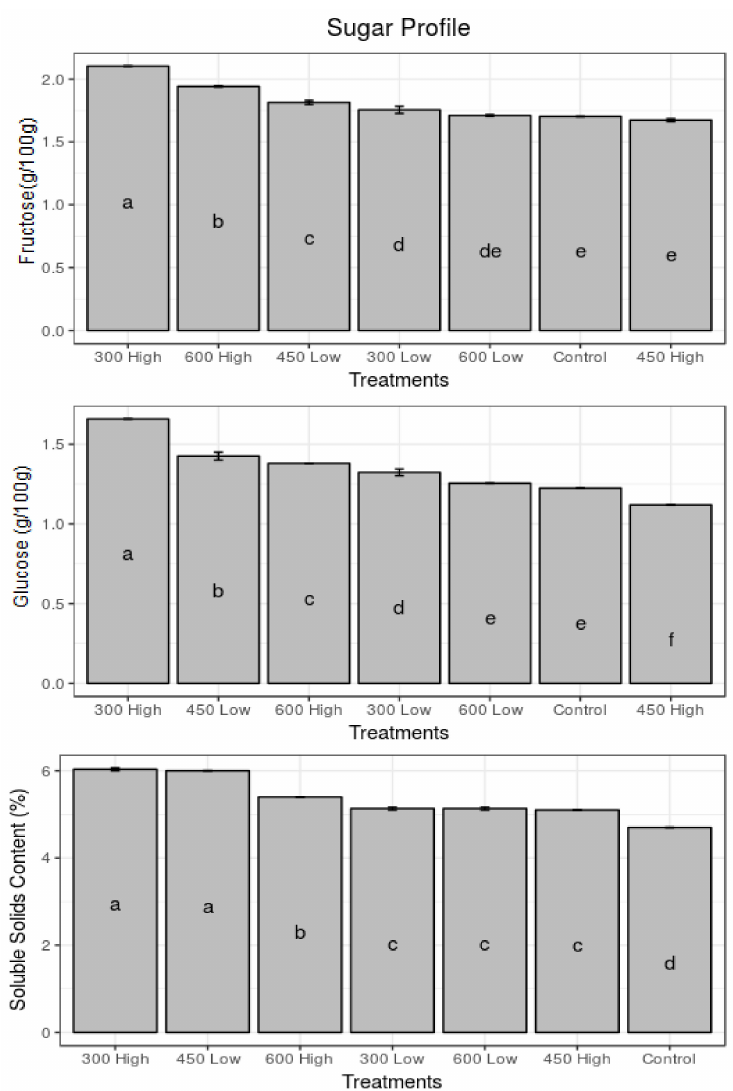
Figure 4. Soluble solids content (SSC), fructose, and glucose contents of tomatoes cultivated in the standard (control) and biochar amended media. Bars represent standard error ( n = 6 for fructose and glucose and n = 3 for SSC). Different letters show significant difference ( p < 0.05) between